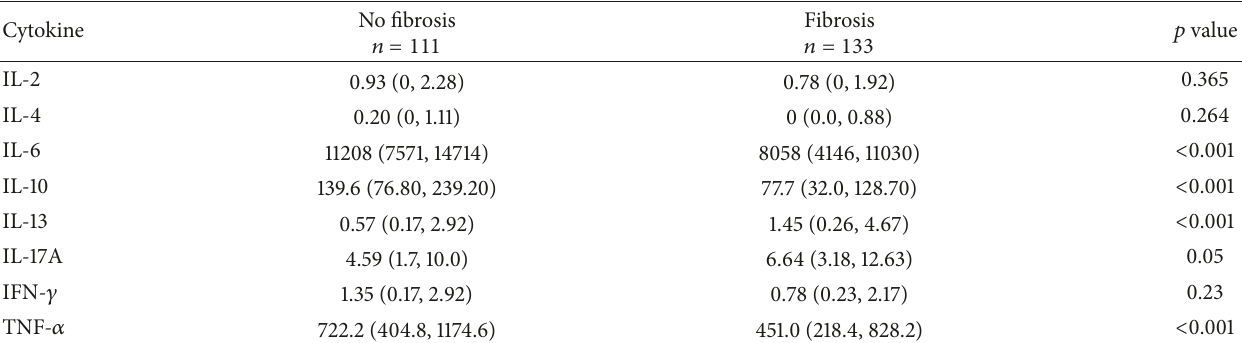
Table 2: Median (interquartile range) cytokine levels (pg/ml) in the nonfibrotic and fibrotic